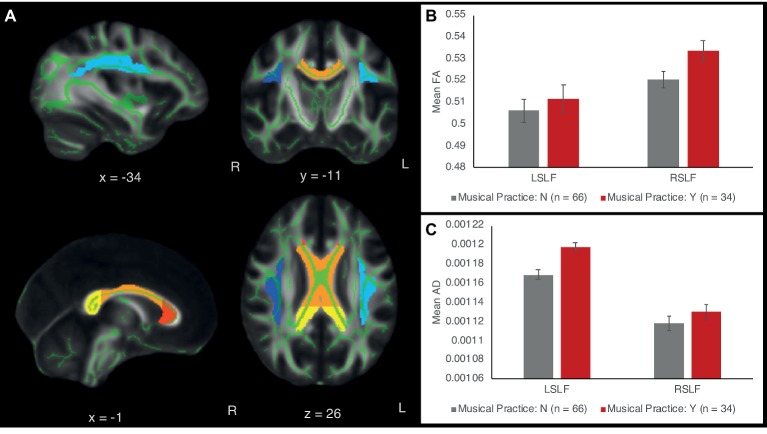

(A) White matter tract ROIs in the left and right superior longitudinal fasciculus (SLF) and the corpus callosum (CC). Light blue = left SLF; dark blue = right SLF; red = genu of CC; orange = body of CC; yellow = splenium of CC. The ROIs are overlaid on the standard white matter skeleton (green) and 1 mm template FA image (grayscale). Green voxels inside the ROIs are averaged across the ROI to obtain mean FA, AD, and RD values across the ROI. (B) FA of the left and right SLF as a function of musical expertise. (C) AD of left and right SLF as a function of musical expertise. Error bars show between-subject standard error of the mean.